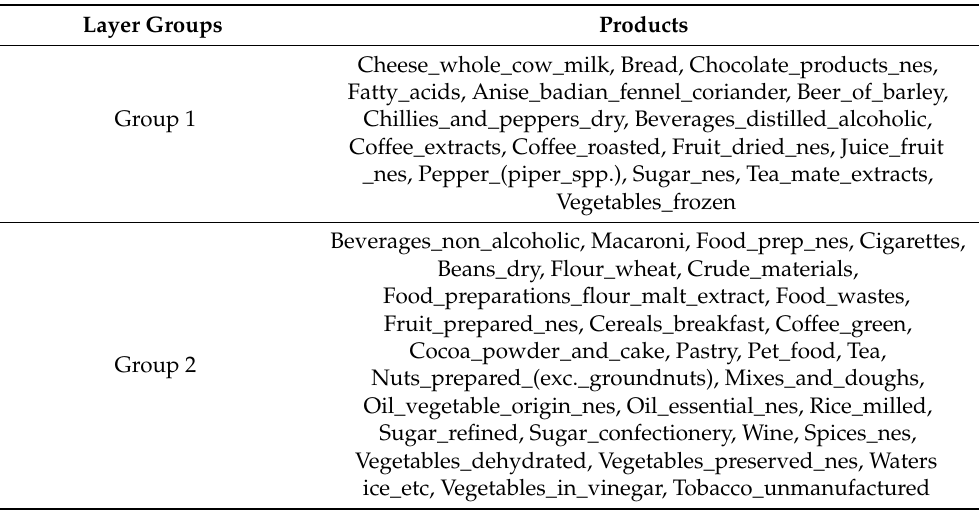
Table 2. Between-layer clustering results obtained by